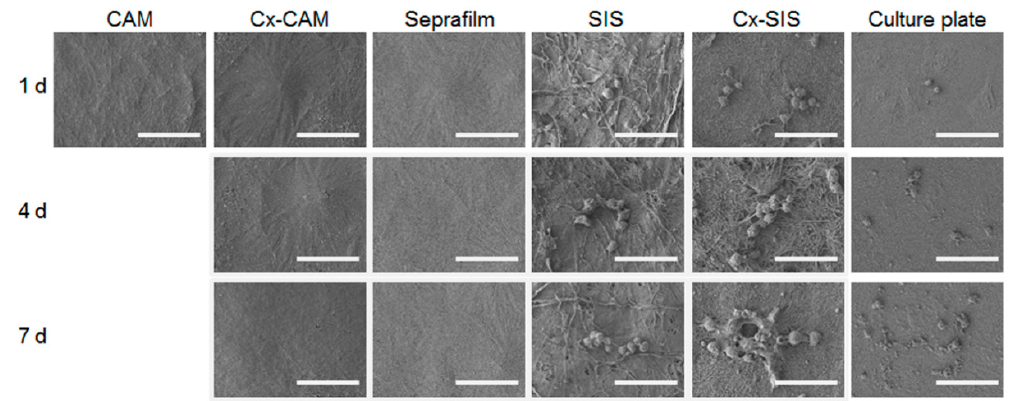
Figure 6. SEM images of HUVECs cultured on CAM, Cx-CAM, SIS, Cx-SIS, Seprafilm, or a culture plate for 1, 4, or 7 days (magnification is 1000 × , and the scale bar represents 50 μ m).